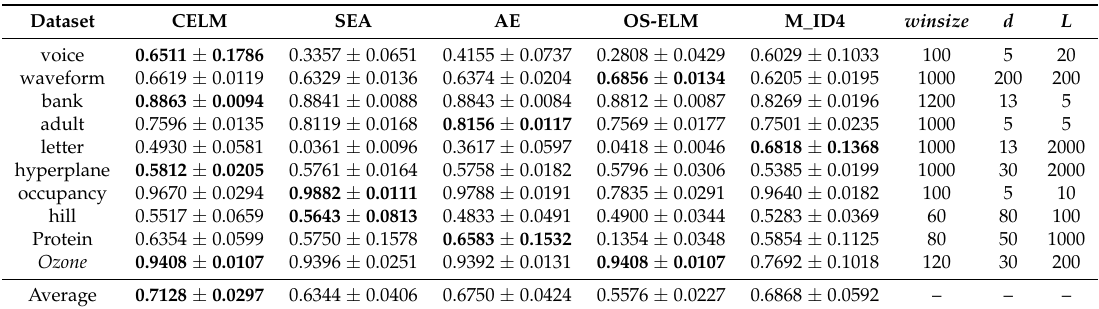
Table 2. The test accuracies of the algorithms on the experimental datasets.